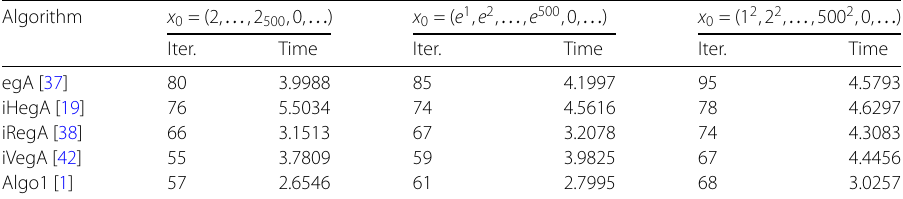
Table 1 Numerical results for Figs. 12–14